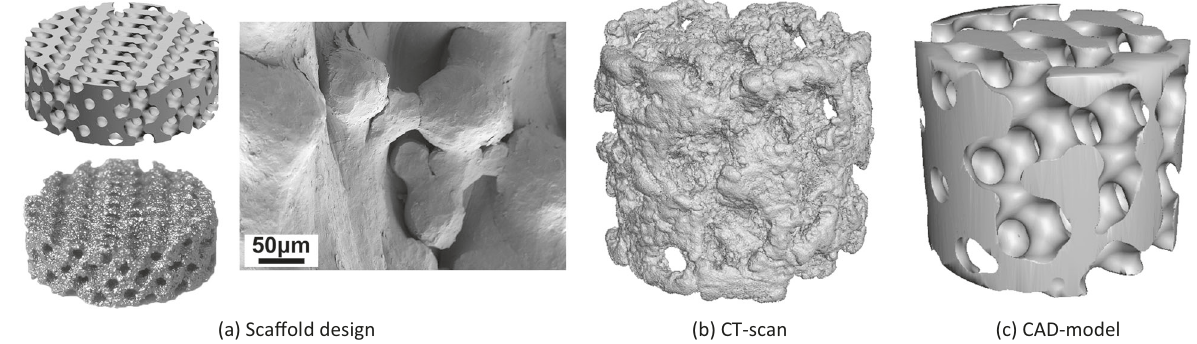
Fig. 2 a Ti64-scaffolds are designed with a pore- and lattice- diameter of 800 µm. Representative images of CAD-model (top, left), EBM manufactured scaffold (bottom, left) and SEM image (right) of a large scaffold. b CT-scan of a manufactured small scaffold based of the CAD- model in